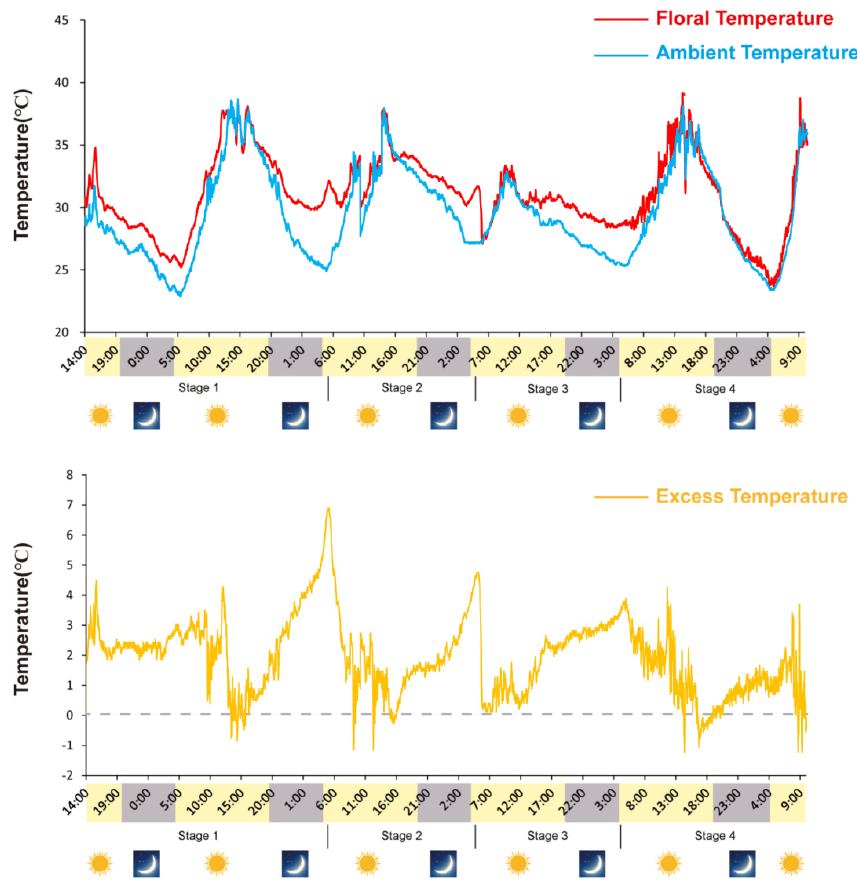
Figure 2. Variations in ambient (Ta) and flower (Ts) temperatures during N. nucifera flowering. Floral thermogenesis occurred during stage 1 (swollen stage), stage 2 (female stage), stage 3 (male stage) and stage 4 (fallen stage) but not during the non-thermogenic bud stage, the thermogenic peak (33.8 °C) was reached during stage 2; the ambient temperature was 22.3 °C.